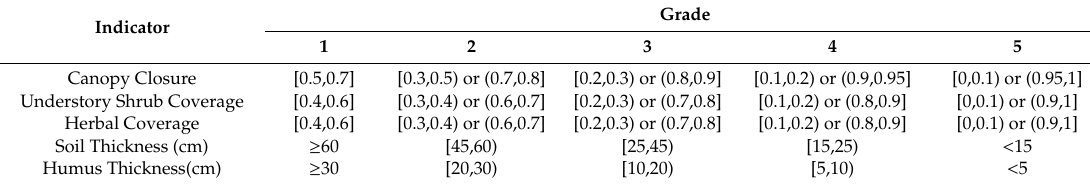
Table 2. Grading criteria of quantitative indicators of the Mount Taishan forest ecosystem health assessment.